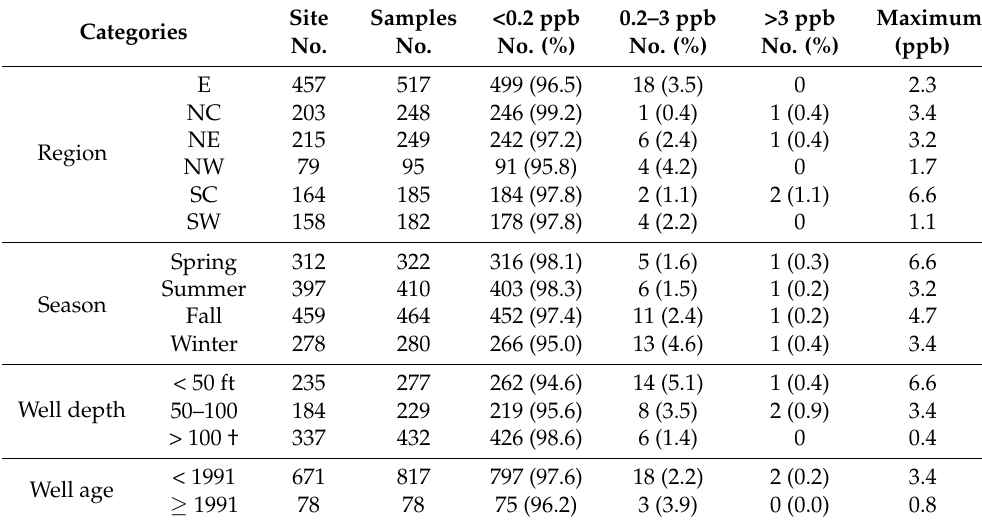
Table 8. Occurrence of Atrazine in Private Wells (Drinking Water MCL = 3 ppb).